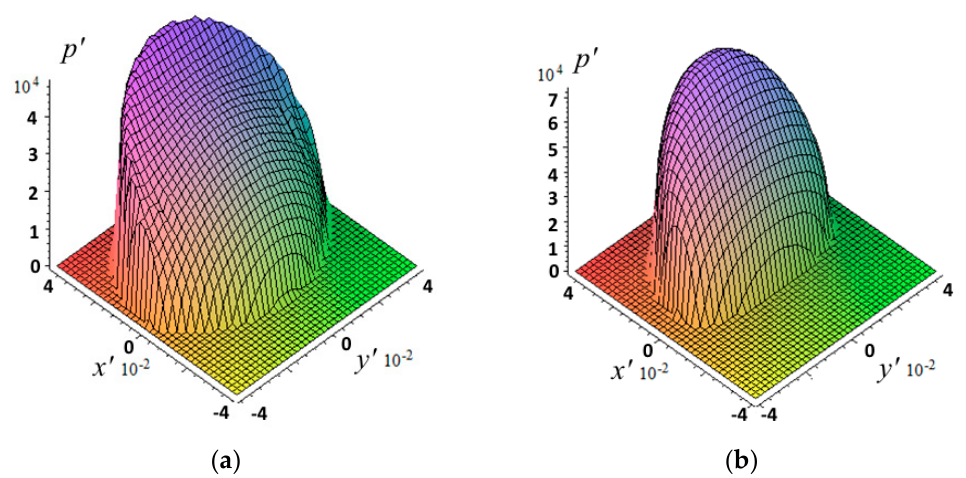
(cid:48) = 4.2 · 10 − 2 , n